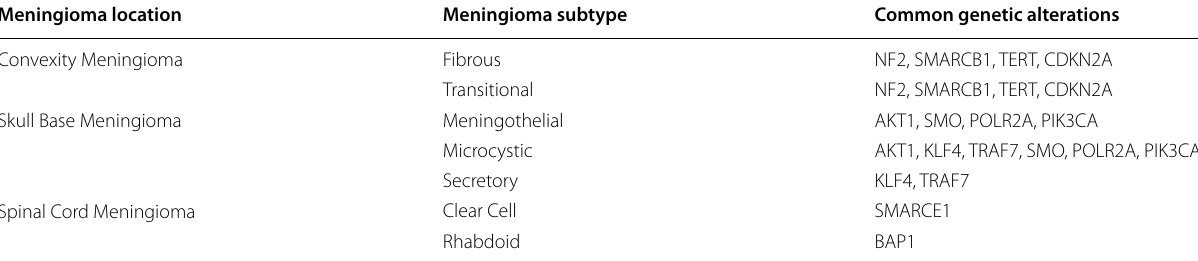
Table 1 Common genetic alteration in meningiomas [42–54]